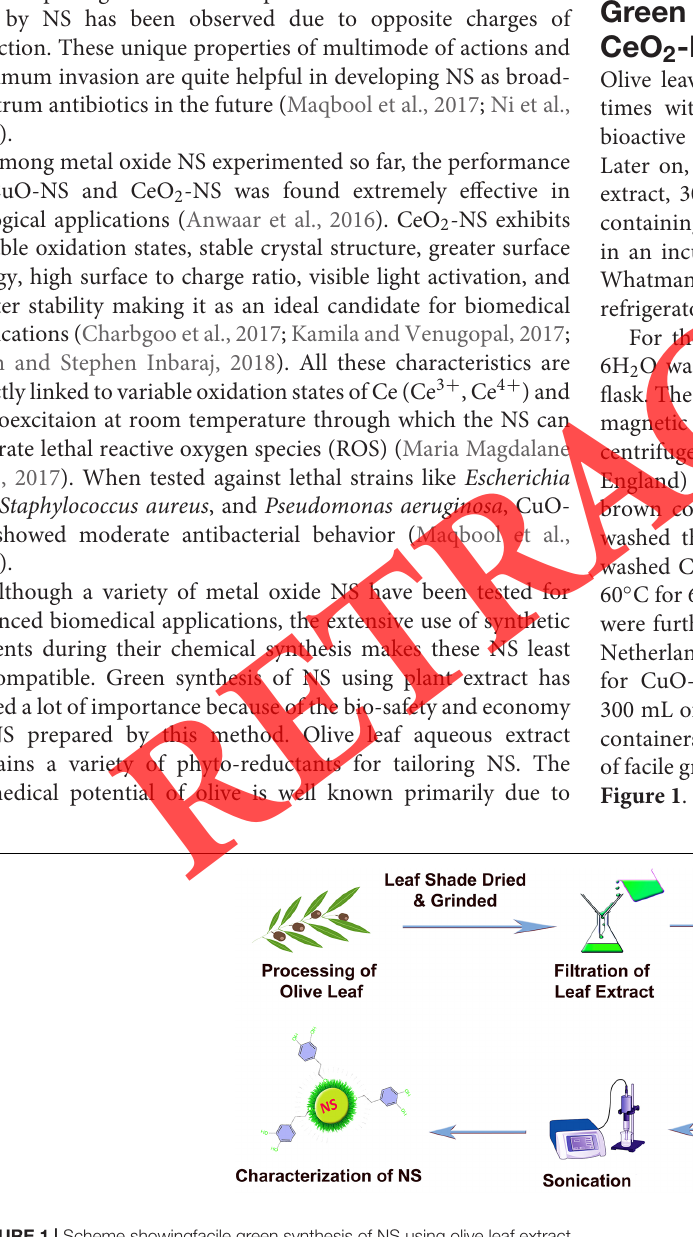
FIGURE 1 | Scheme showingfacile green synthesis of NS using olive leaf